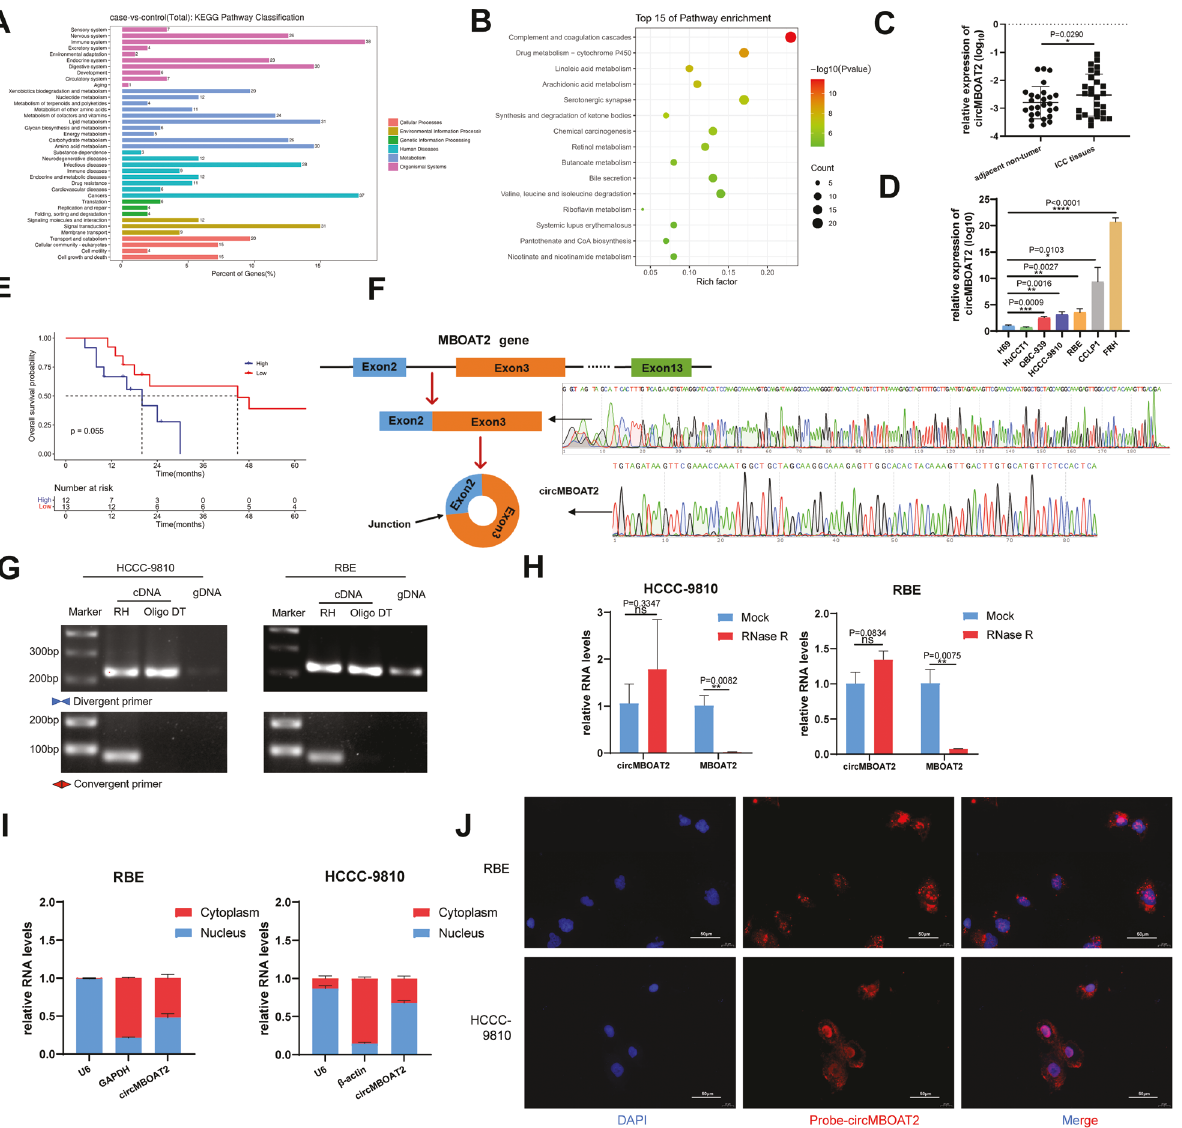
Fig. 1 CircMBOAT2 is an upregulated circRNA associated with lipid metabolism in ICC. A , B KEGG pathway classi fi cation analysis and KEGG enrichment analysis for top 15 pathways in ICC tissue compared to adjacent non-tumor tissue by RNA sequencing. C The qRT-PCR method was applied to detect the expression levels of circMBOAT2 in 27 ICC patients and normal tissues adjacent to cancer. The expression of circMBOAT2 was normalized to β -actin. Signi fi cant differences between groups were analyzed by paired sample t -test. D The relative expression of circMBOAT2 in six human ICC cell lines and one human normal bile duct epithelial cell line (H69) by qRT-PCR. E K – M curve showed the prognosis of ICC patients with different expressions of circMBOAT2. F Explanation of the illustrated genomic loci of MBOAT2 and validation strategy for circular exons 2 – 3 (circMBOAT2). Sanger sequencing after PCR revealed MBOAT2 exons 2 – 3 and “ head and tail ” splicing of circMBOAT2. G PCR analysis of circMBOAT2 by divergent primers and convergent primers in cDNA and genomic DNA. RH